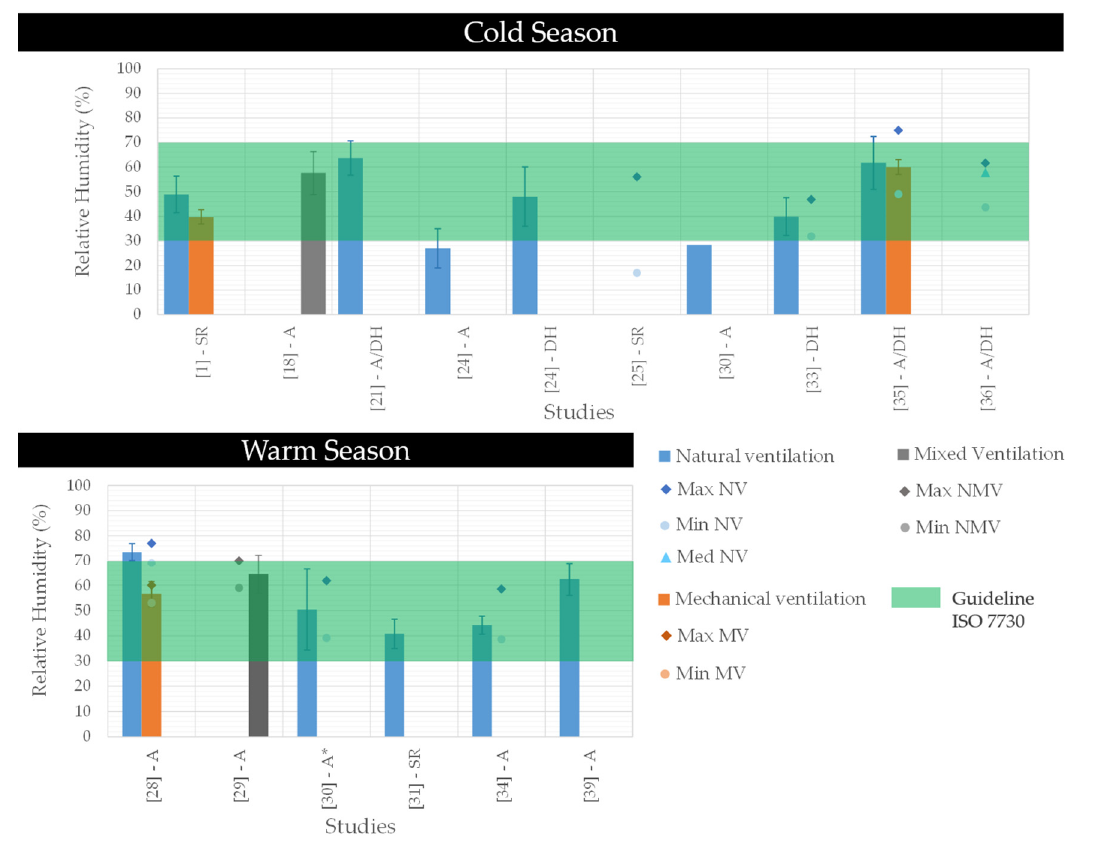
Figure 3. Relative humidity levels monitored in bedrooms during warm and cold seasons, with natural (NV), mechanical (MV) and mixed (NMV) ventilation settings. Studies index is regarding type of building: A—apartment; A/DH—mixed (apartment and detached house); DH—detached house; SR—scholar residence. Bars provide mean values (along with standard deviation when available). Max, min and med stand for maximum, minimum and median values, respectively. *—This study does not specify the type of bedroom ventilation.